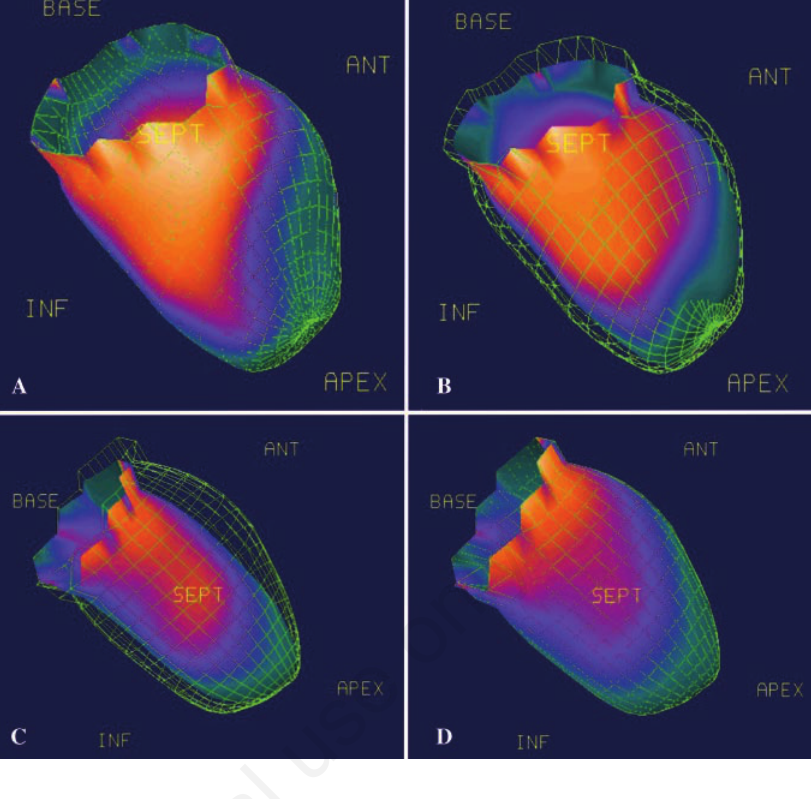
Figure 1. Radioisotope-left ventriculography at symptoms onset (A, diastole and B, sys- tole) and two years later after chemotherapy (C, diastole and D,